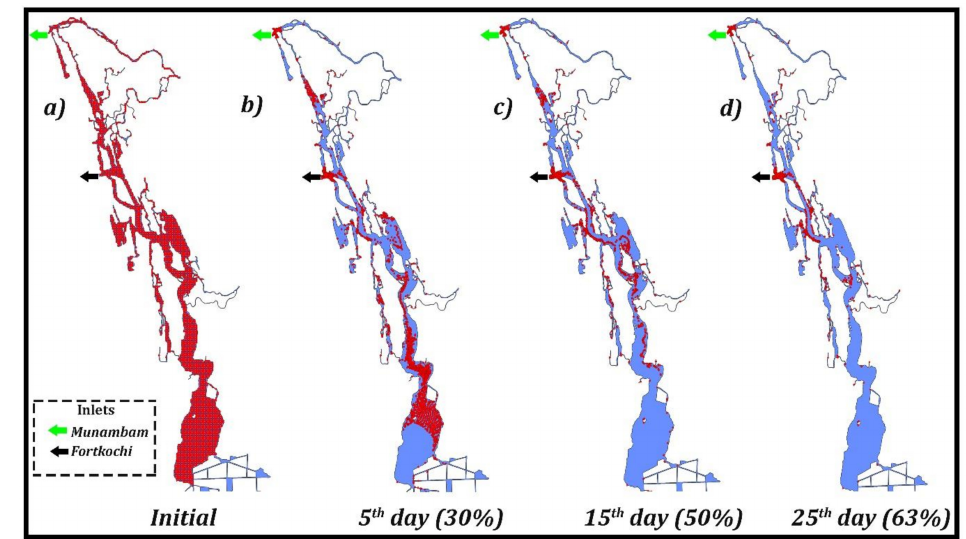
Figure 12. Spatial distribution of particles after the initial period ( a ), with 30% ( b ), 50% ( c ) and 63% ( d ) of the particles flushed out from the model domain with varying climatological freshwater discharge at the upstream boundaries during the summer monsoon.